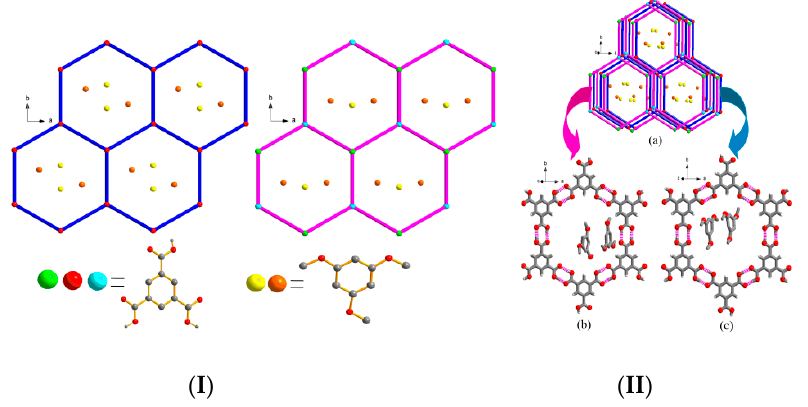
Figure 1. ( I ) TMB molecules located in the channels formed hydrogen-bonded 6-rings in compound ( 1 ); ( II ) two hydrogen-bonded 6-membered rings in compound ( 1 ). ( 1 ); ( II ) two hydrogen-bonded 6-membered rings in compound ( 1